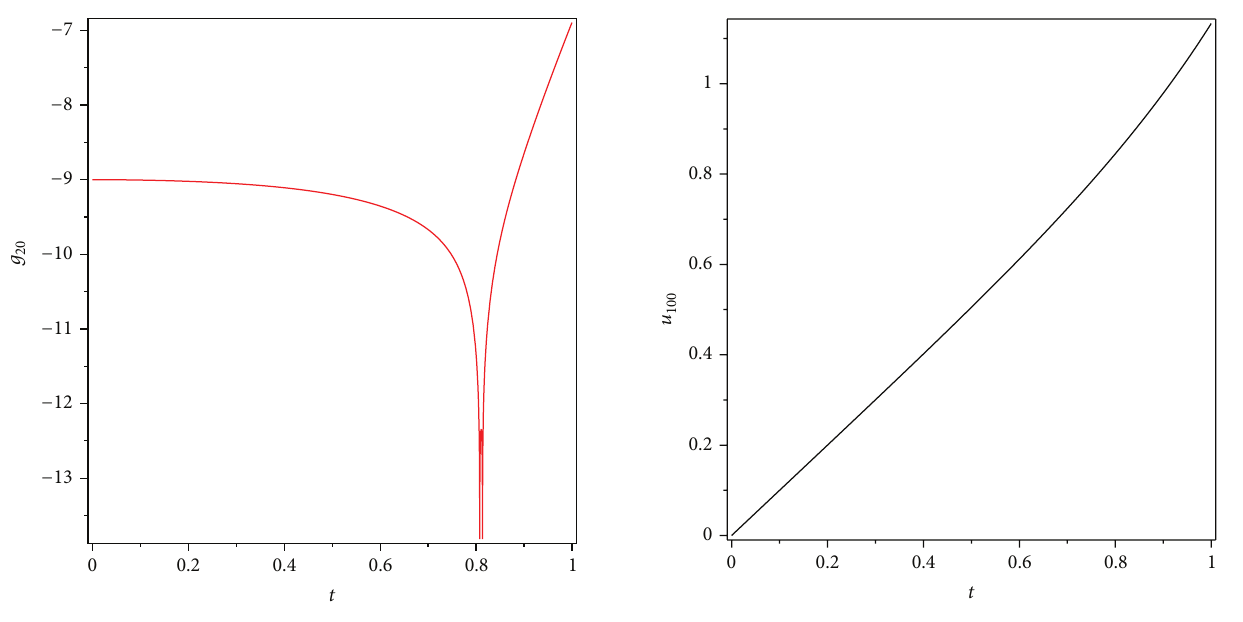
Figure 3: Approximate solution of